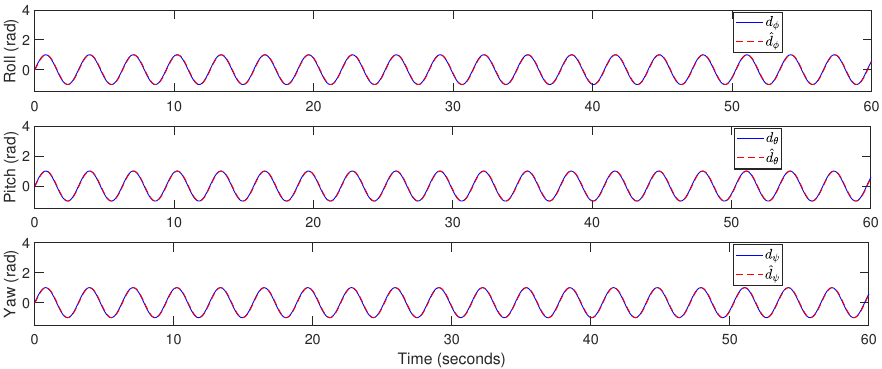
Figure 14. Disturbance observer outcome for attitude subsystem with periodic disturbance.